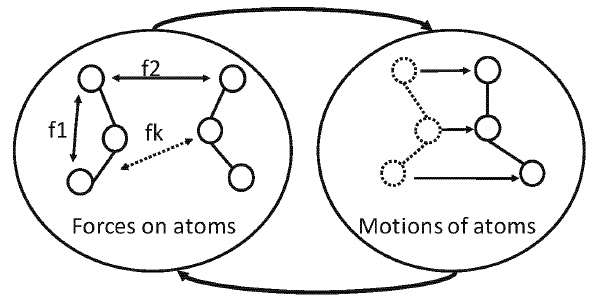
Fig. 1. Molecular dynamics simulation model. Force com- putation and motion update of the atoms are repeated for millions of iterations.